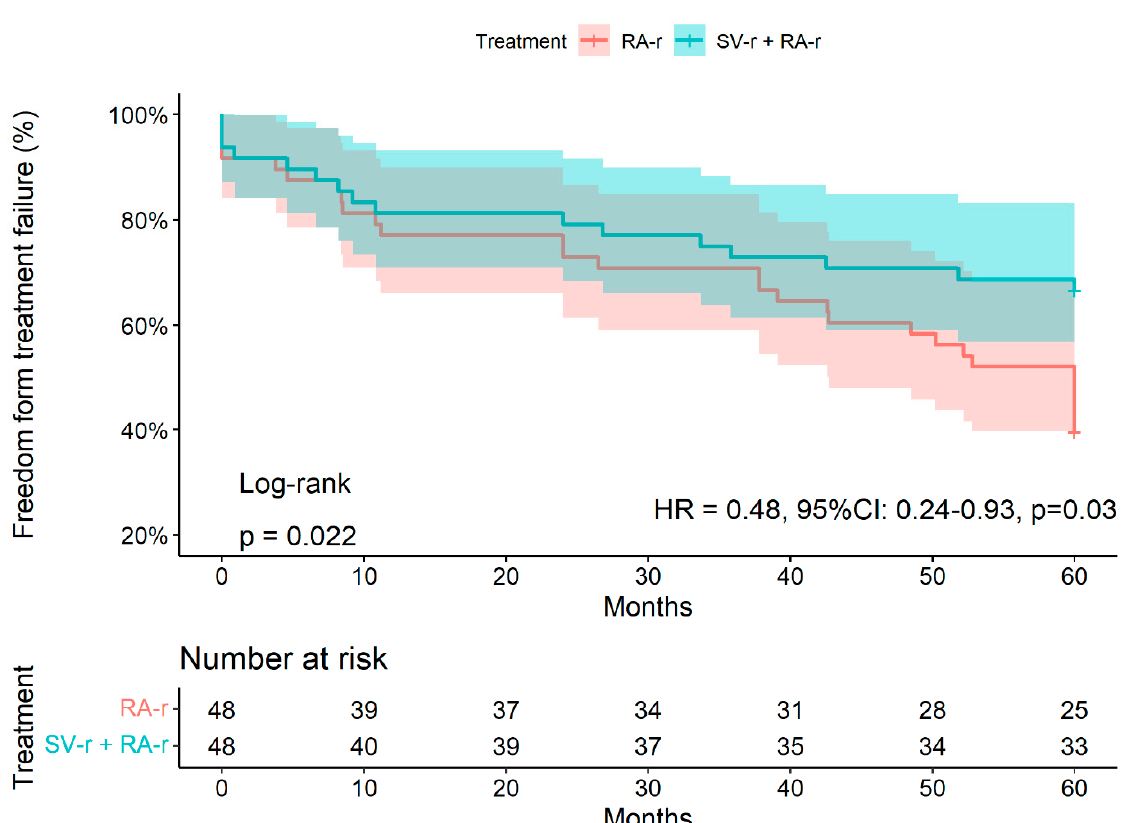
Figure 1. Kaplan–Meier curves for freedom from treatment failure (composite endpoint of death, MV reoperation, moderate to severe (3+) MR, or severe (4+) MR) within 5 years of follow-up after either subvalvular repair combined with restrictive annuloplasty repair (SV-r + RA-r group) or restrictive annuloplasty repair (RA-r group) alone for treatment of ischemic mitral regurgitation. Vertical marks indicate that patients’ data were censored at that point. Abbreviations: MV: mitral valve; MR: mitral regurgitation .